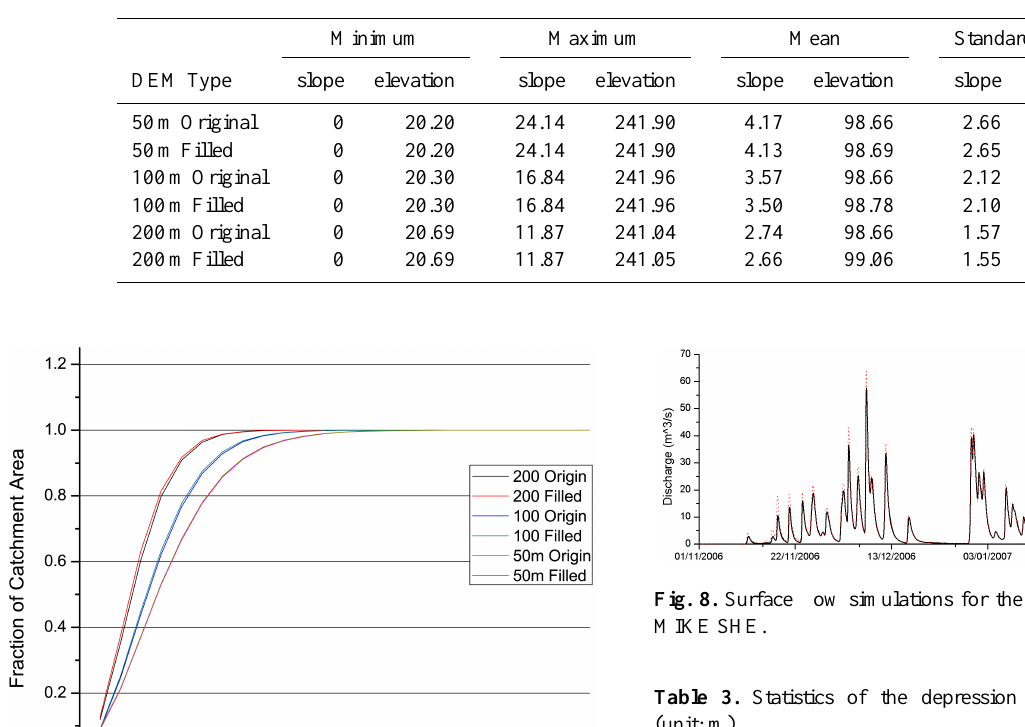
Table 2. Statistics of Slopes (unit: degree) and elevations (unit: m).